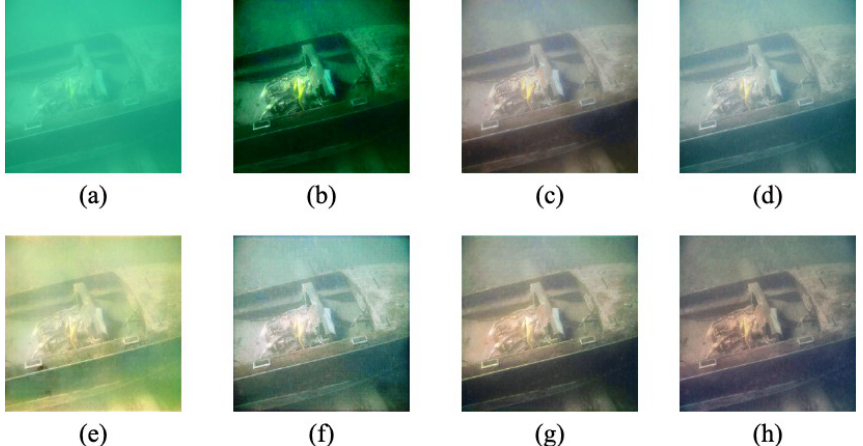
Figure 1. Comparison of the results of different methods for processing a real underwater picture. Our method restores the chromatic aberration and enhances the contrast. ( a ) Raw, ( b ) UDCP [2], ( c ) WaterNet [5], ( d ) Ucolor [9], ( e ) UGAN [11], ( f ) FUniE-GAN [6], ( g ) Ours, ( h ) Ground